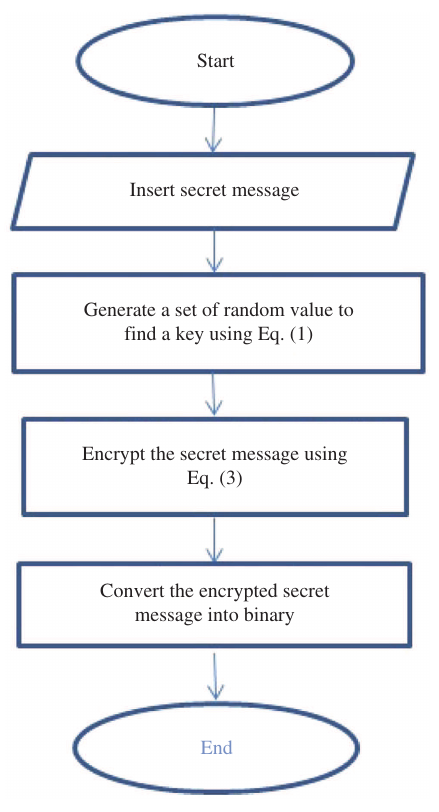
Figure 1: The Flow Chart of Encrypted Secret Message Process. that, the frames utilized as a cover are chosen randomly. Afterward, the pixels inside the chosen frame uti-